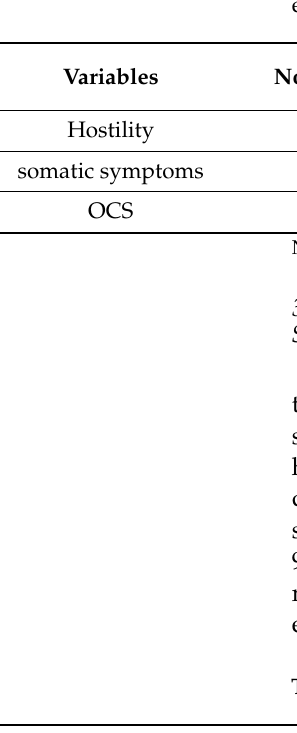
Table 3. Internalizing/externalizing problem indicators ( x ± s ) associated with sleep disturbance examined by multivariate binary logistic regression analyses ( n = 2134).